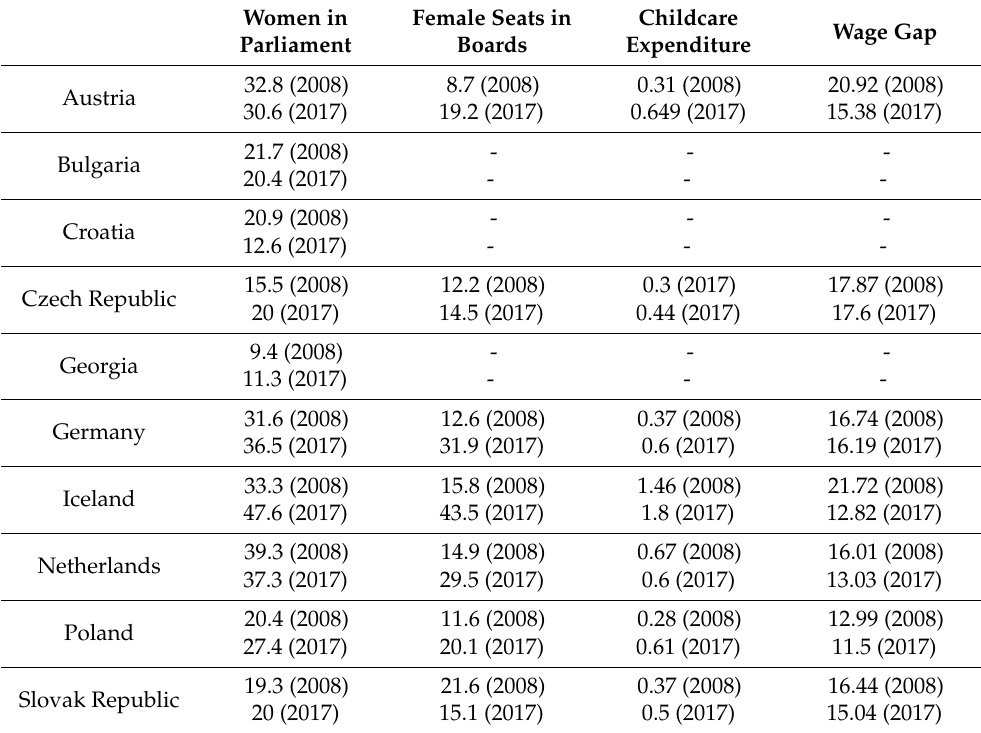
Table A4. Distribution of independent variables by